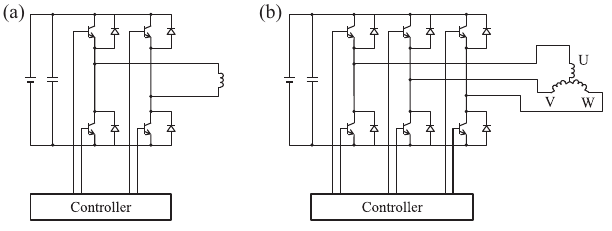
FIG. 8. Power-supply configurations: (a) separated power supply, (b) single power